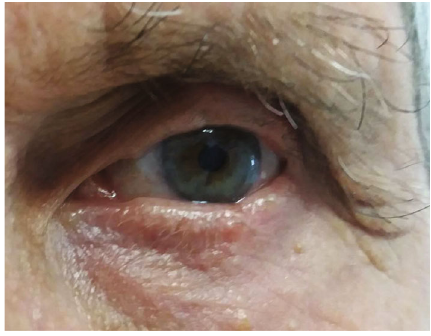
Figure 2: Clinical outcome 6 months after the surgery in Case No. 2.